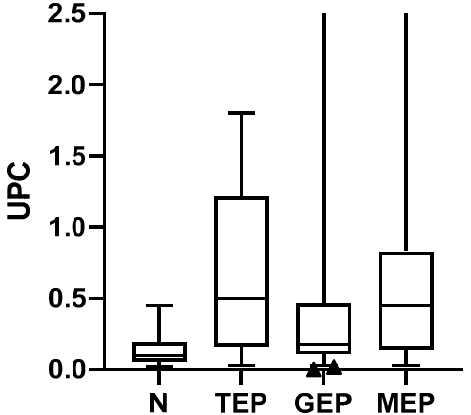
Figure 3. UPC value with respect to the electrophoretic pattern. Kruskal-Wallis ( p < 0.0001) post hoc Dunn’s test minimum and maximum values are presented, in addition to quartiles 1 and 3. Abbreviations: UPC, proteinuria: creatininuria ratio; N, negative; TEP, tubular electrophoretic pattern; GEP, glomerular electrophoretic pattern; MEP, mixed electrophoretic pattern.